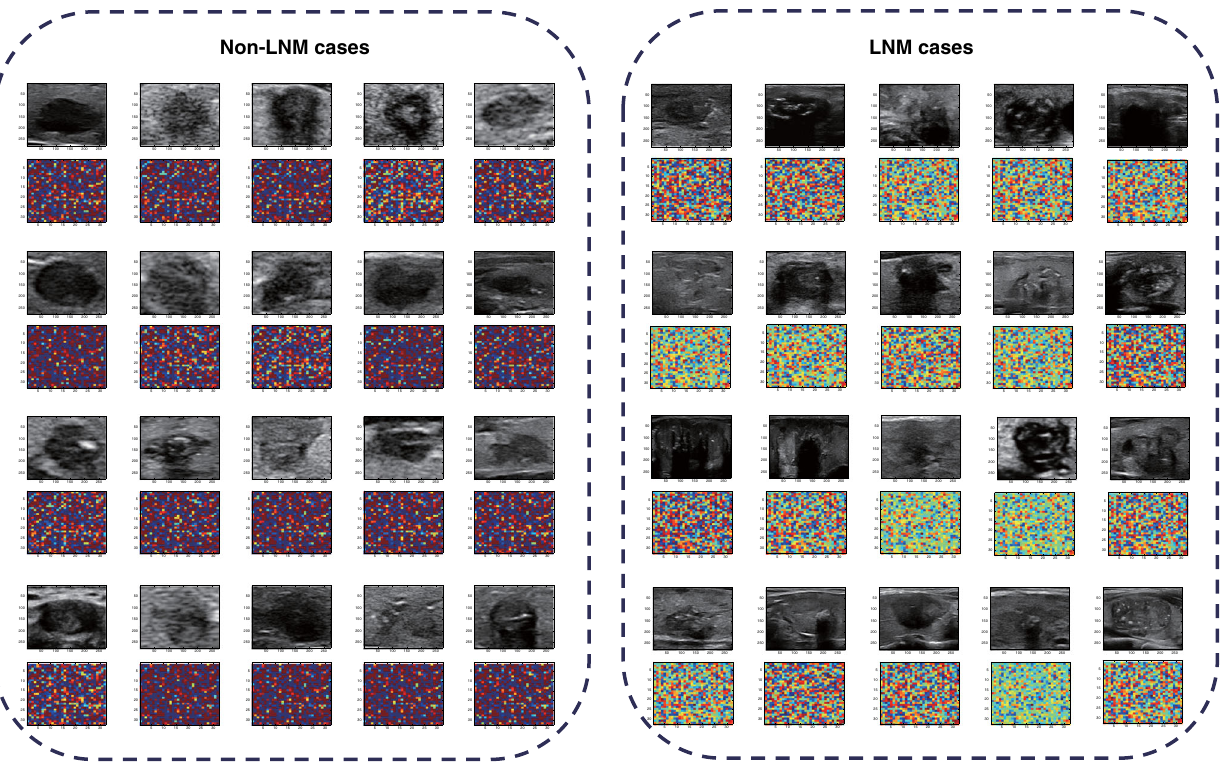
Fig. 4 Visualization of network features of 20 cases with and without LNM, respectively. The left side shows the network features of 20 cases without LNM, and right side shows 20 cases with